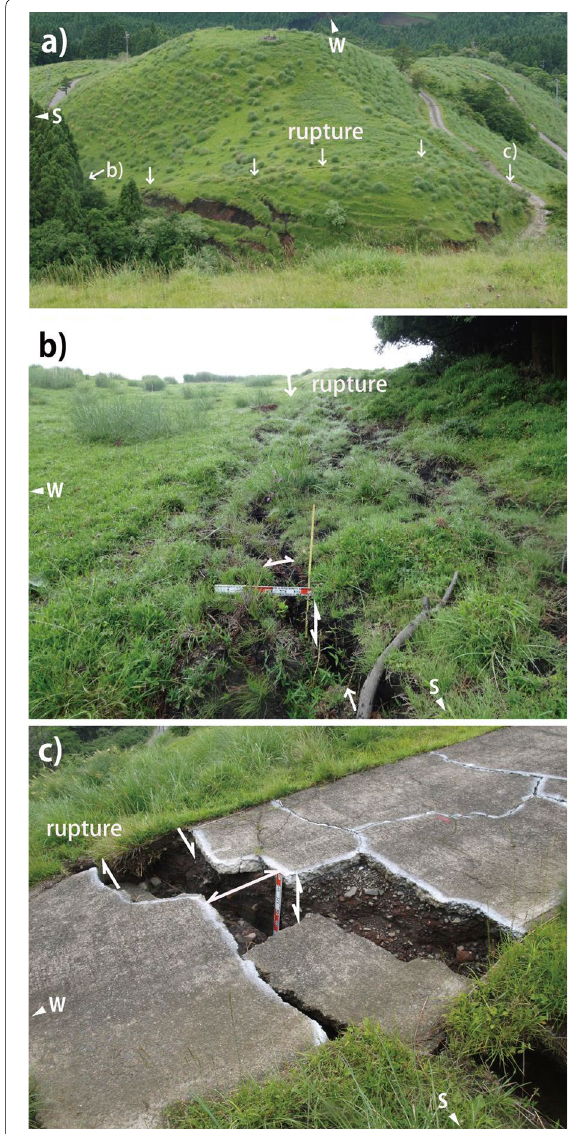
Fig. 7 Bended rupture at north Yoshioka. a Surface rupture that appears on the ridge near Yoshioka; b surface rupture at Site 24 with left strike-slip showing N24°E strike and 85°N dip with 30 cm opening and 15 cm west side down. c Surface rupture at Site 25 showing a N50°W strike and a 63°S dip. The surface with 5 cm right strike-slip shows a N31°W strike and an 80°S dip with 50 cm opening and 20